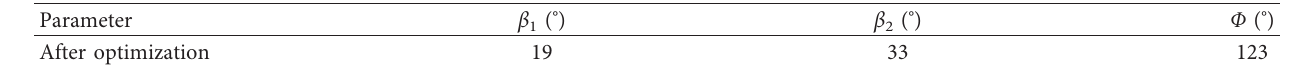
Figure 26: Cloud chart of impeller deformation under different inlet angles. Table 5: Optimization results of the blade angle of the plastic centrifugal